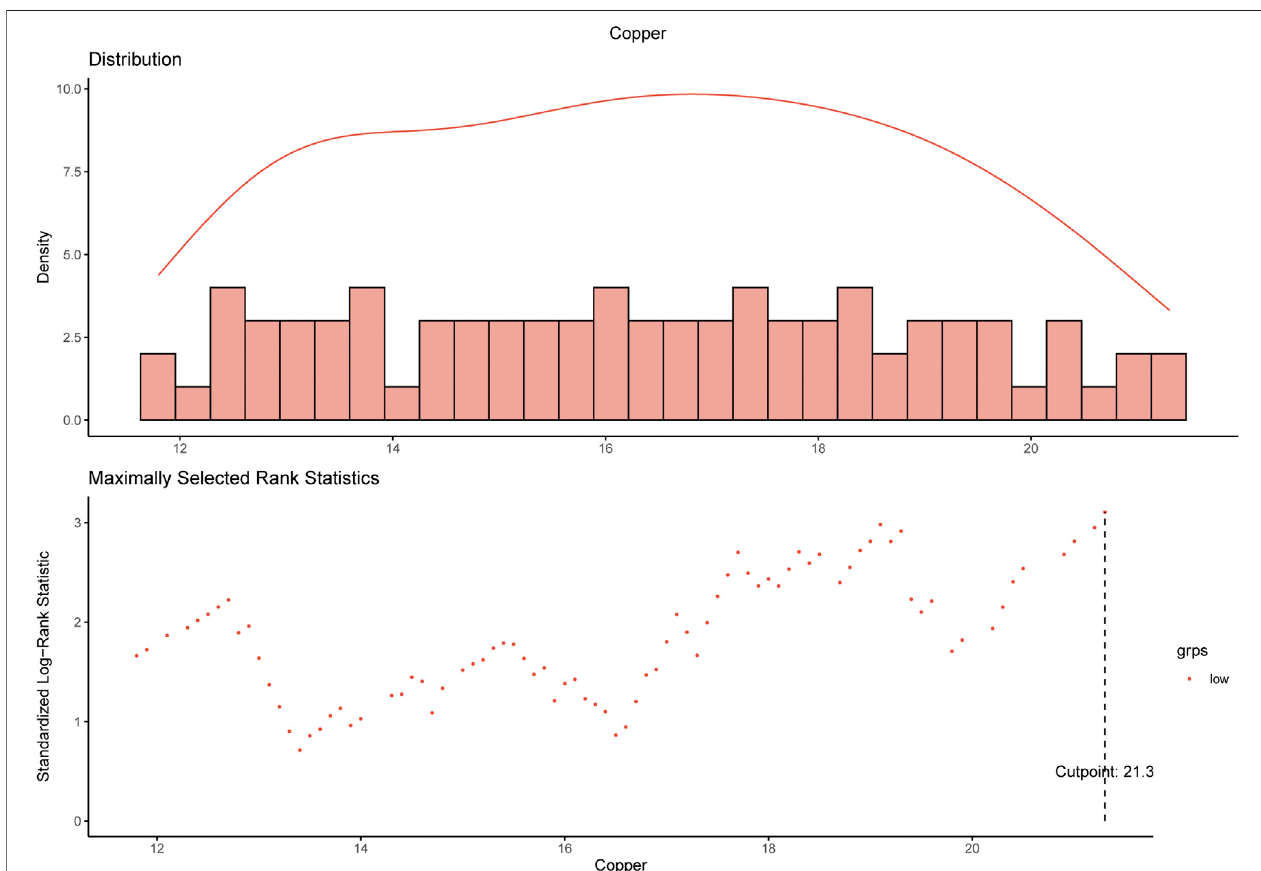
FIGURE 2 | Determination of the cut-off value of 21.3 μ mol/L for serum copper level by using maximally selected log-rank statistics.